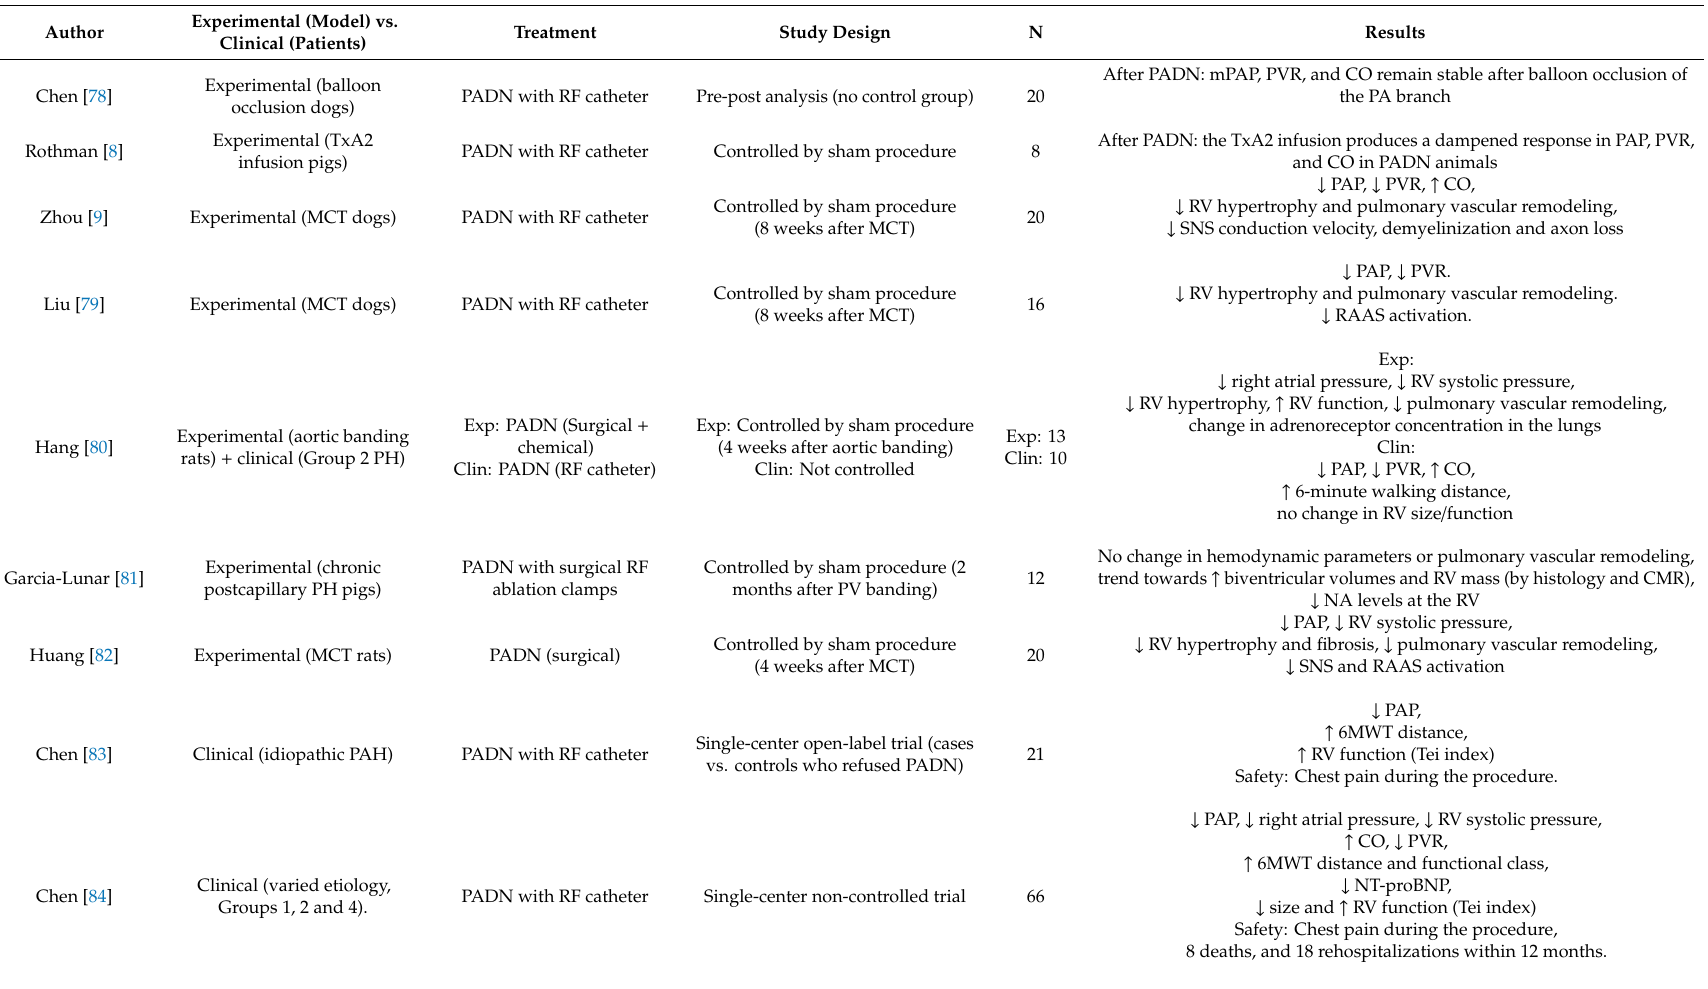
Table 3. Invasive strategies targeting the ANS in